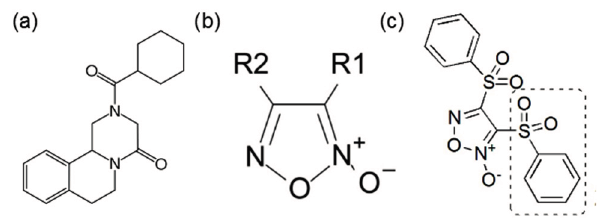
Figure 1. Molecular formula of ( a ) praziquantel; ( b ) a generic oxadiazole N- oxide and ( c ) 3,4-bis(phenylsulfonyl)-1,2,5-oxadiazole N 2 -oxide (VL16E). One of the phenylsulfonyl structural motifs of VL16E is